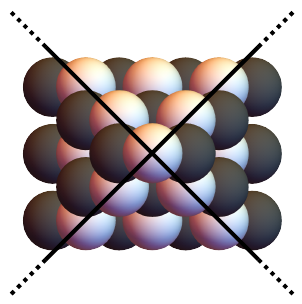
Figure 5 . The canonical crystal for the resolved conifold (called pyramid partition). It corresponds to the so-called non-commutative DT chamber [17], i.e. m = 1